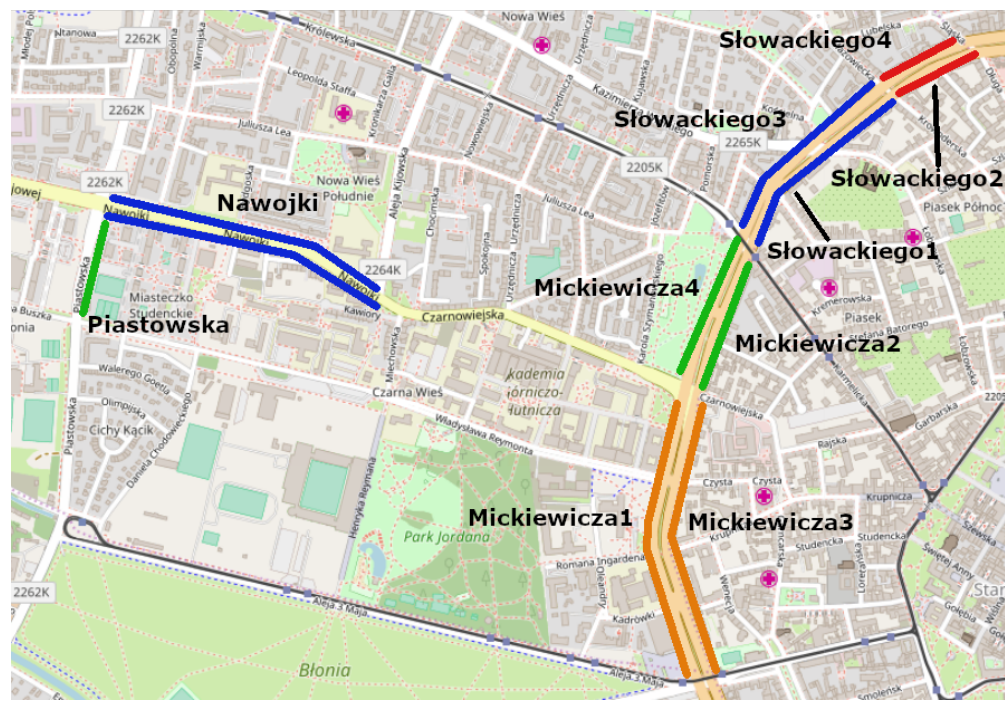
Figure 1. Area under consideration.